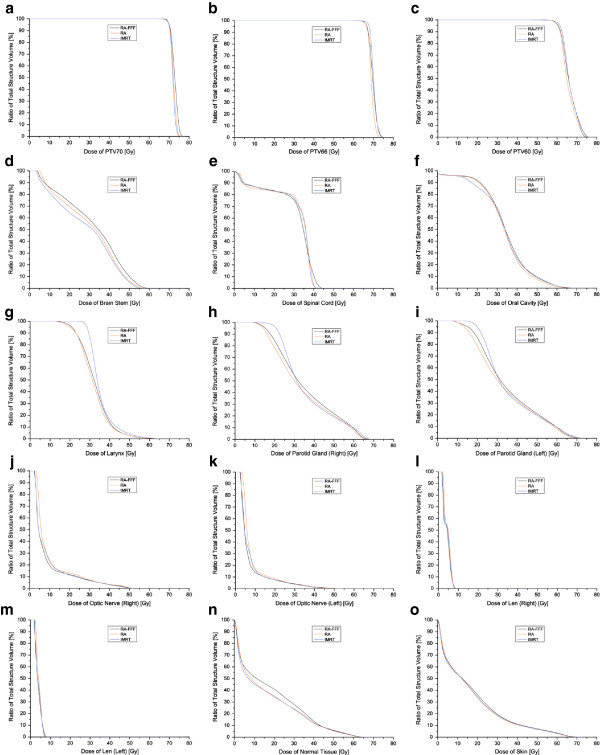
Dose-volume histograms for three techniques.